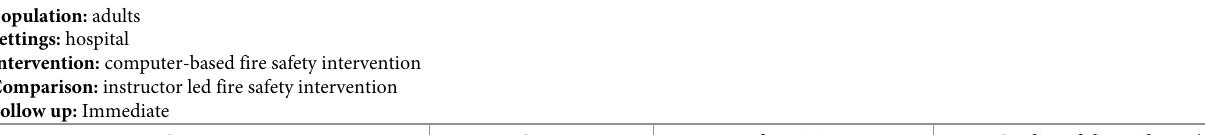
Table 6. Summary of findings. Computer-based vs Instructor-based.